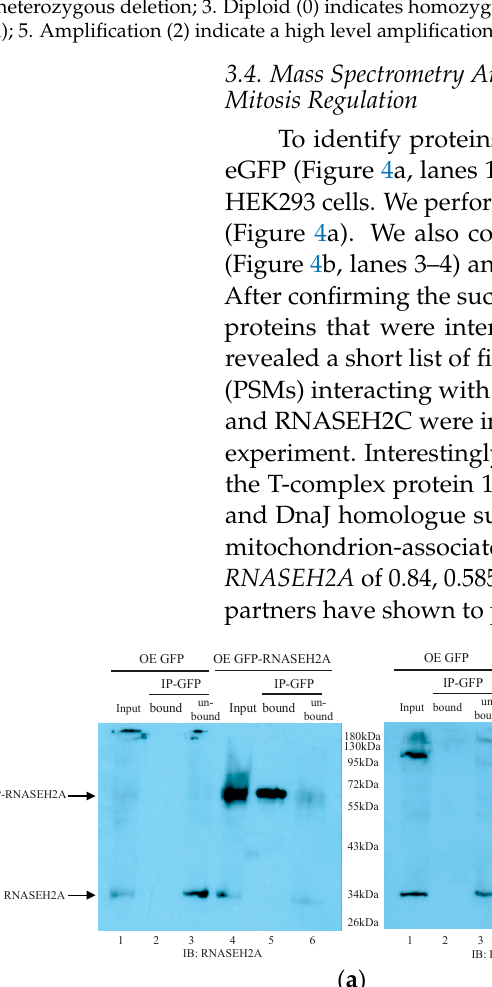
T-complex protein 1 subunit theta